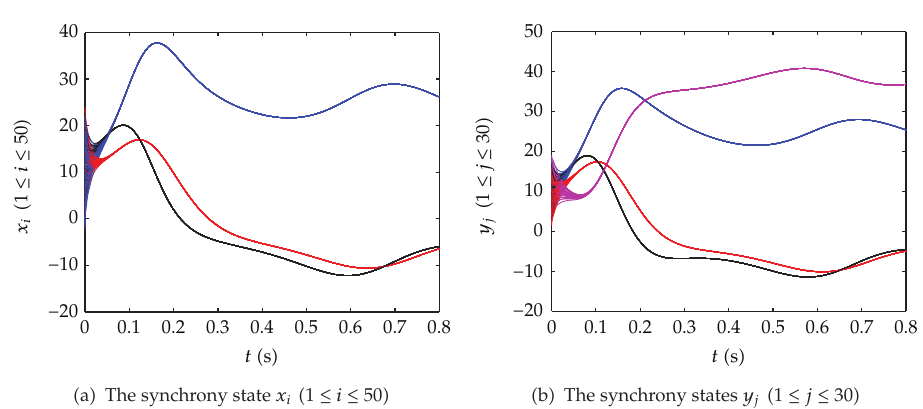
Figure 1: Cluster synchronization in the linearly coupled network (cid:4) 2.1 (cid:5) with 50 lorenz oscillators in the x -cluster and 30 hyperchaotic L¨u oscillators in the y